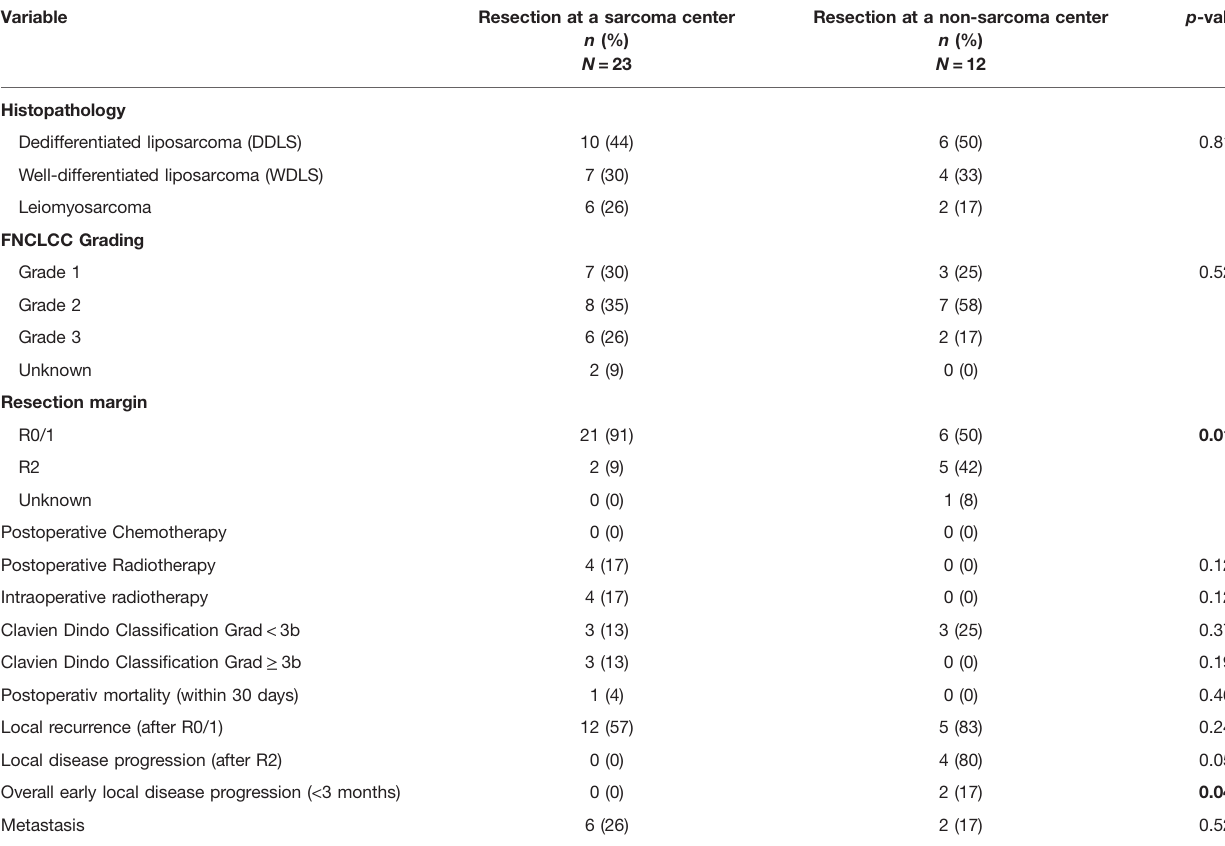
Table 2 | Perioperative data of patients undergoing surgery for retroperitoneal sarcoma according to the type of hospital where the resection was performed.